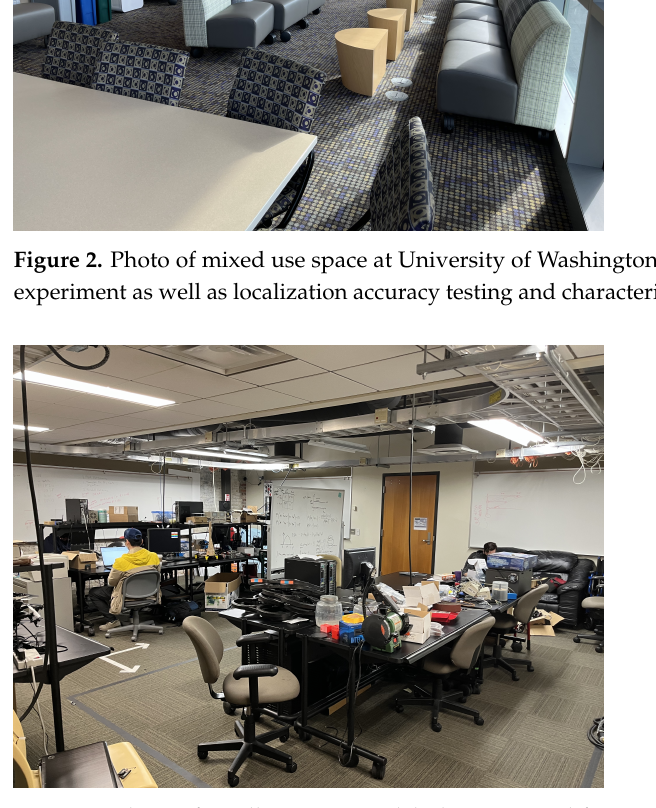
Figure 3. Photo of small engineering lab that was used for range accuracy experiment as well as localization accuracy testing and characterization. The black tape shown on the floor constituted one of the paths that was repeatedly used during the experiments discussed in this